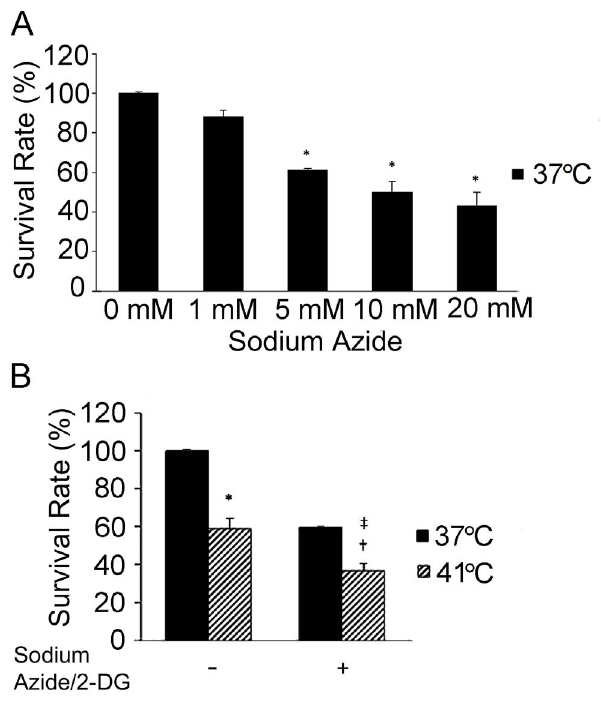
Figure 1. Temperature increase exacerbated sodium azide/2- DG-induced cell death. (A) Sodium azide caused dose-dependent cell death. Neuronal death was induced with different concentrations of sodium azide plus 0.5 mM 2-DG for a period of 1 hour. The time point of cell collection for the analysis was decided based on the findings from our preliminary studies. Cell survival was detected with trypan blue exclusion assay. Error bars represent mean 6 SEM. n=4. * denotes significant difference from 37 u C control cell (0 mM) ( p , 0.01). (B) Increased temperature resulted in more cell death. Cells were treated as indicated for a period of 1 hour and cell survival was detected with trypan blue exclusion assay. * denotes significant difference from 37 u C control ( p , 0.01). { denotes significant difference from 37 u C with sodium azide/2-DG ( p , 0.01). ` denotes significant difference from 41 u C without sodium azide/2-DG ( p ,